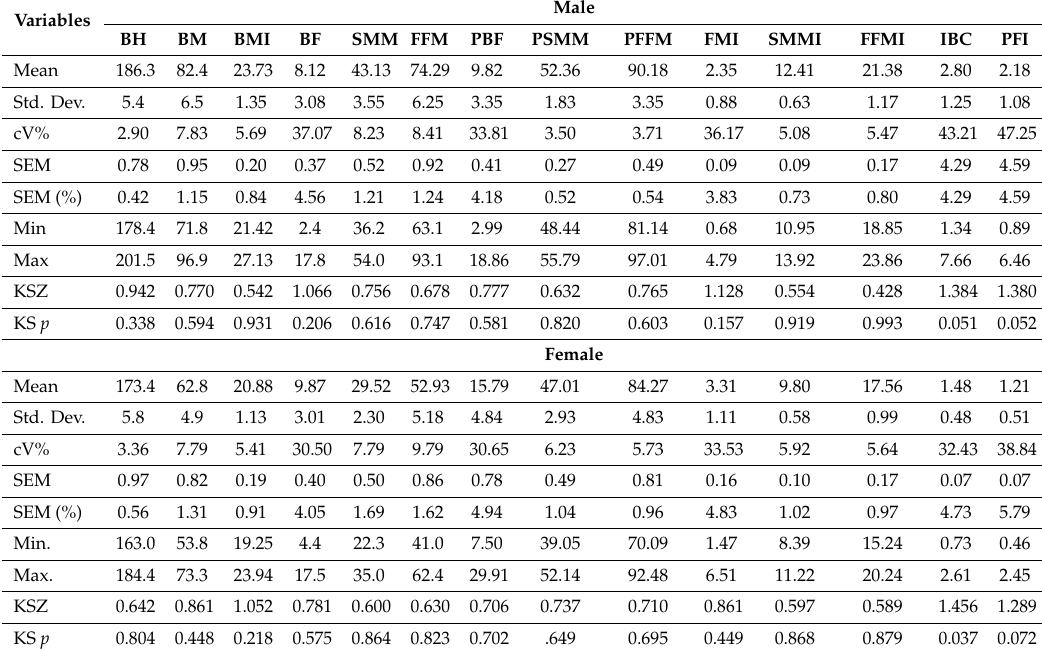
Table 1. Descriptive statistics for male and female swimmers.